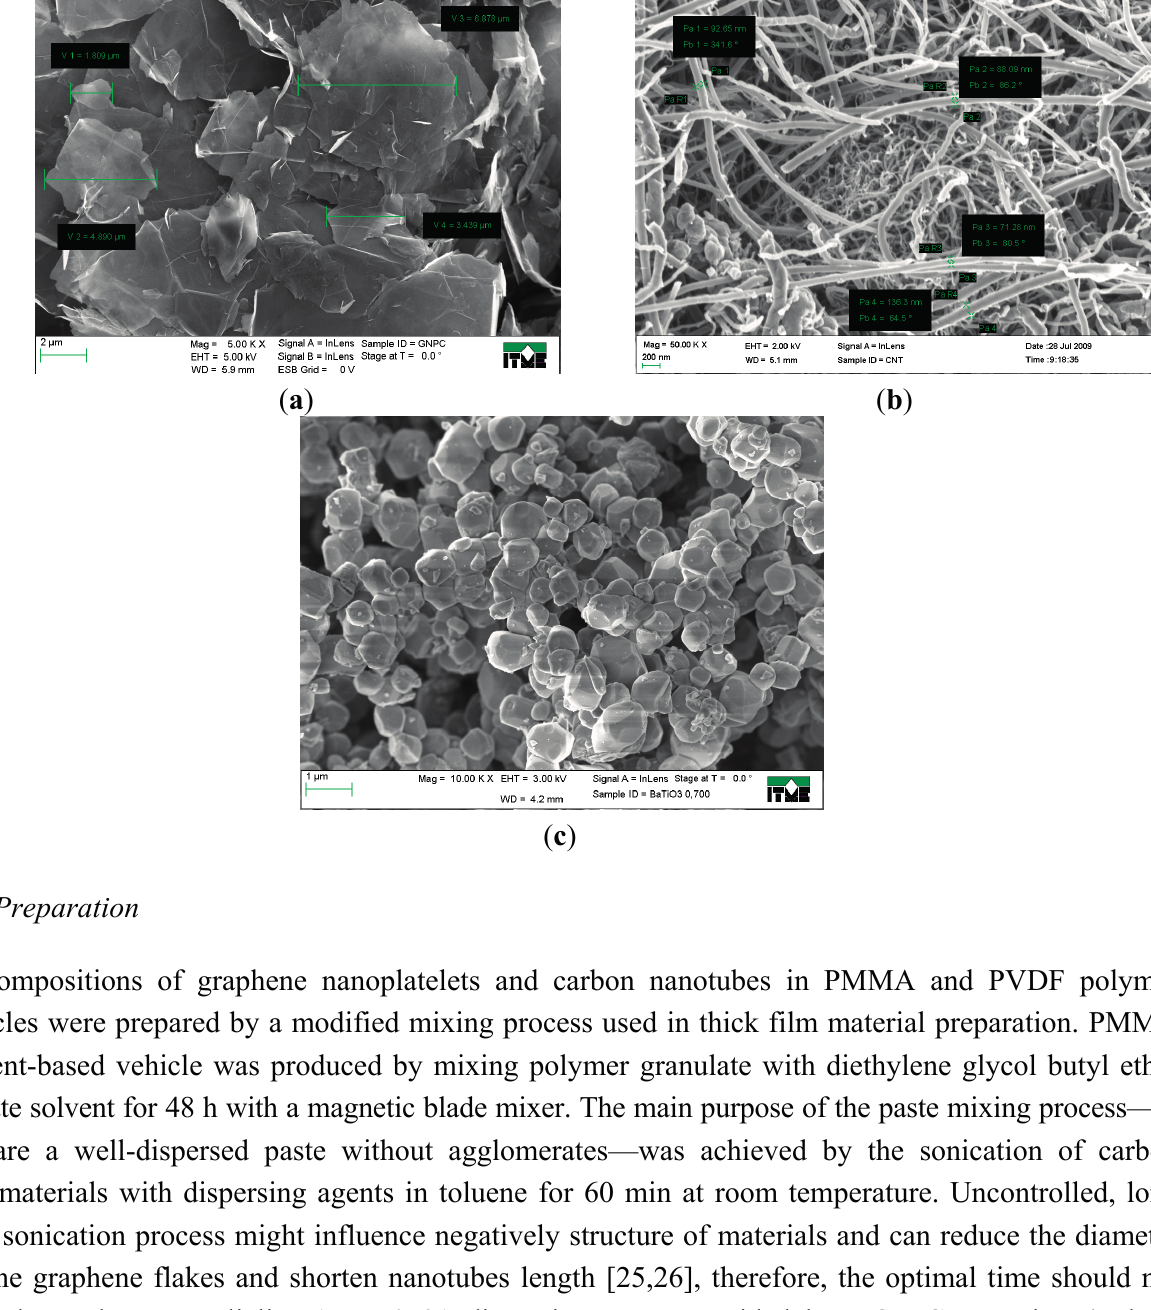
Figure 1. SEM image of ( a ) Graphene Nanoplatelets (GNP), ( b ) Multiwall Carbon Nanotubes (MWCNTs), ( c ) Barium titanate (BaTiO